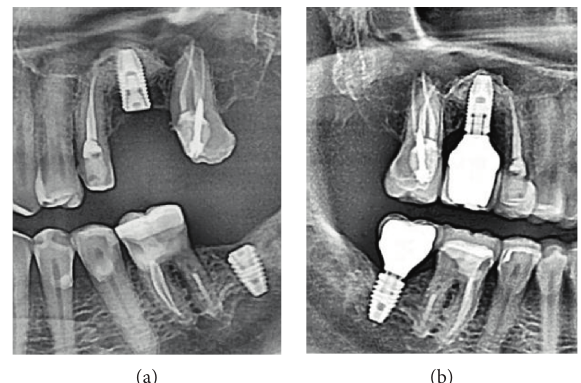
Figure 24: X-ray control: (a) implant integration after 16 weeks; (b) bone remodeling around the implant neck 4 weeks after placement of the platform switching